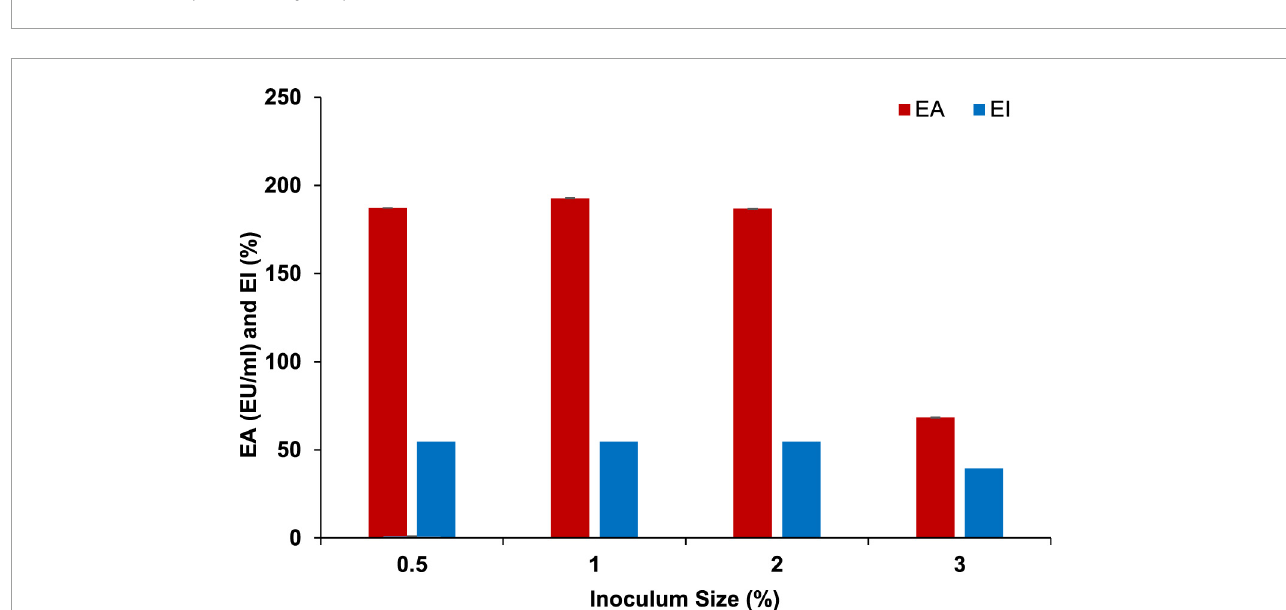
FIGURE1 Time course of BE production by Parapedobacter indicus.